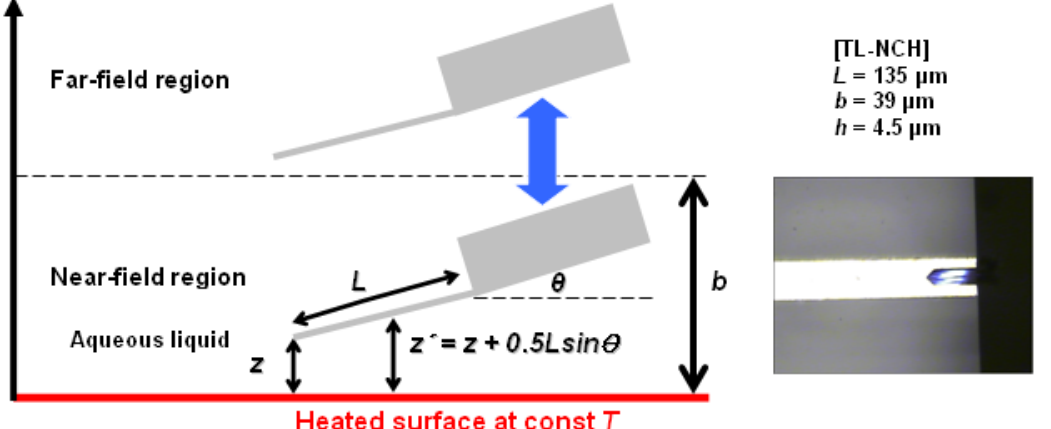
Figure 3. A schematic drawing of the near-field microscale thermometry in aqueous liquid using a tipless microcantilever and a microphotograph of the micro-line heater and